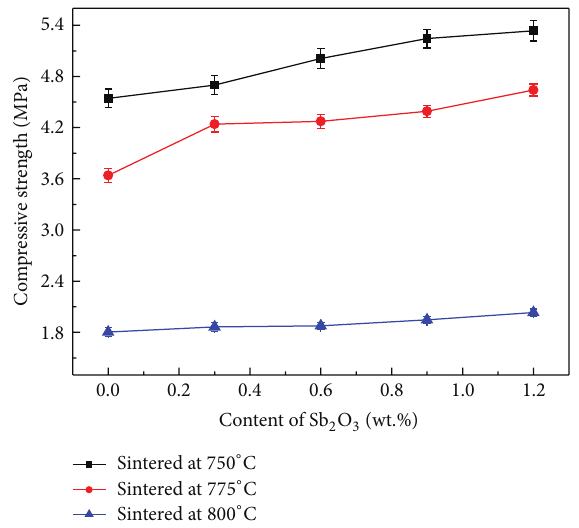
Figure 2: Changes of the compressive strength with Sb 2 O 3 content for the foam glass at different sintered temperatures.